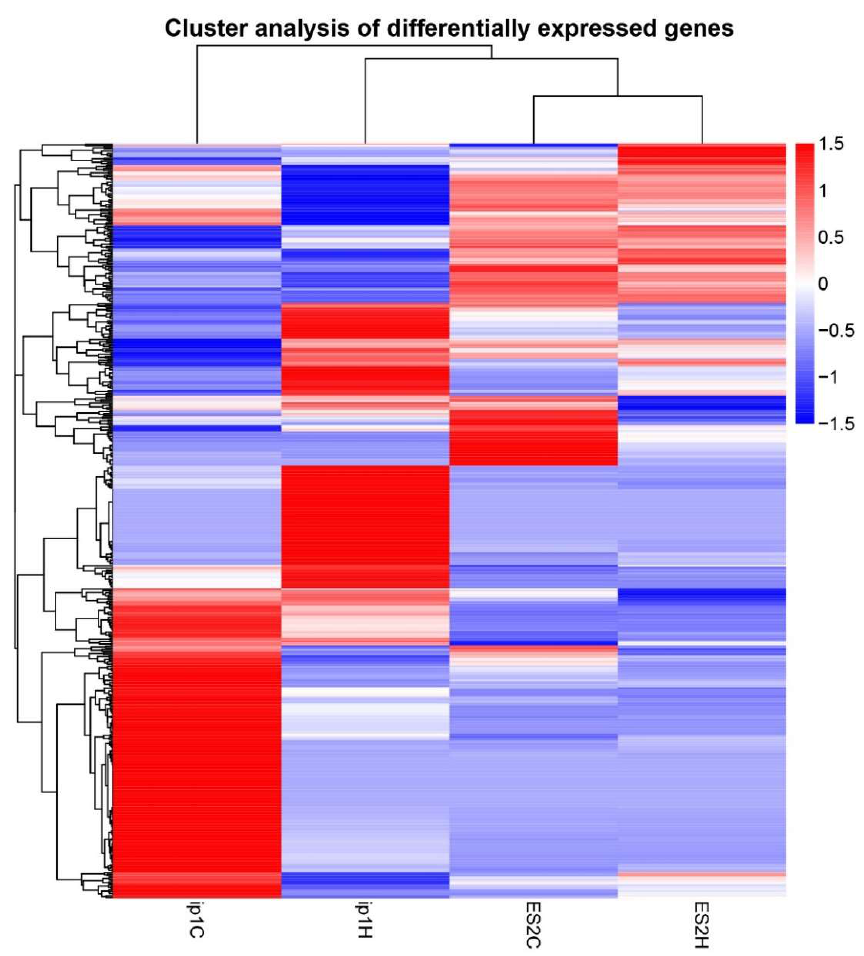
Figure 4. Cluster analysis of differential expression genes in paired tumors treated with HCFs and the control tumor not treated with films. Tumor tissues were obtained from the control (ip1C) and HCFs with 12–16 μm pores (ip1H) in SKOV3ip1 cells, and from the control (ES2C) and HCFs with 5–8 μm pores (ES2H) in ES2 cells. The hierarchical clustering analysis was performed with the log10(FPKM+1) of union differential expression genes of all comparison groups under different experimental conditions. Data colored in the red–white–blue scheme indicate a relatively higher, average, and lower expression, respectively.